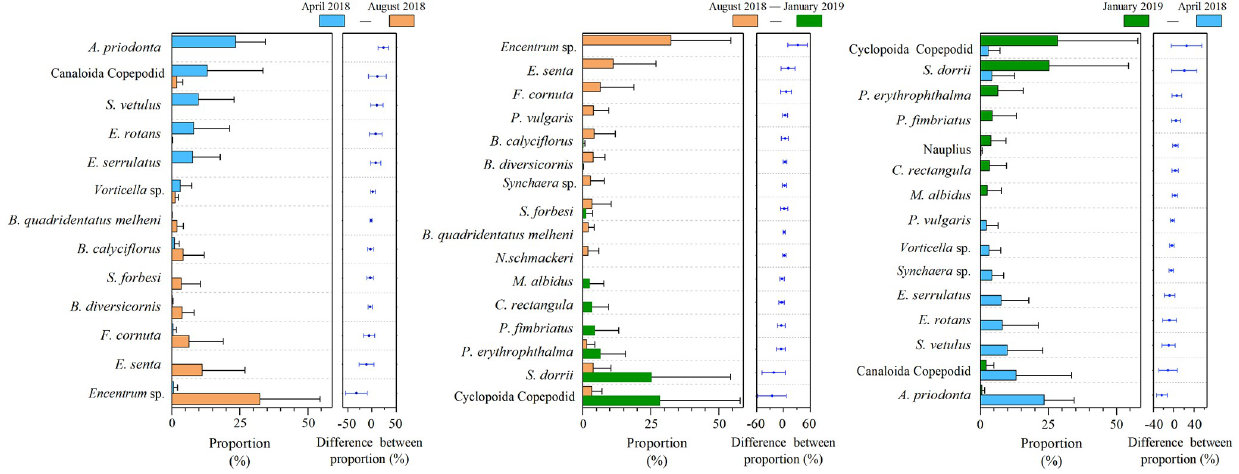
Fig 5. The species shift of zooplankton in the three seasons. Only showed the species those proportion differences were more than